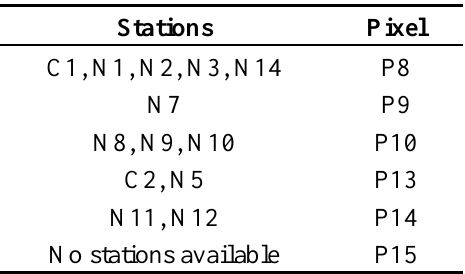
Table 1. In-situ stations that are overlain by a